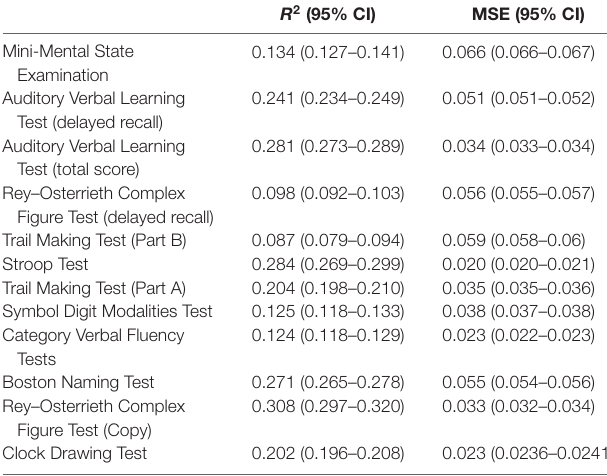
TABLE 3 | R 2 and mean squared error (MSE) in support vector machine